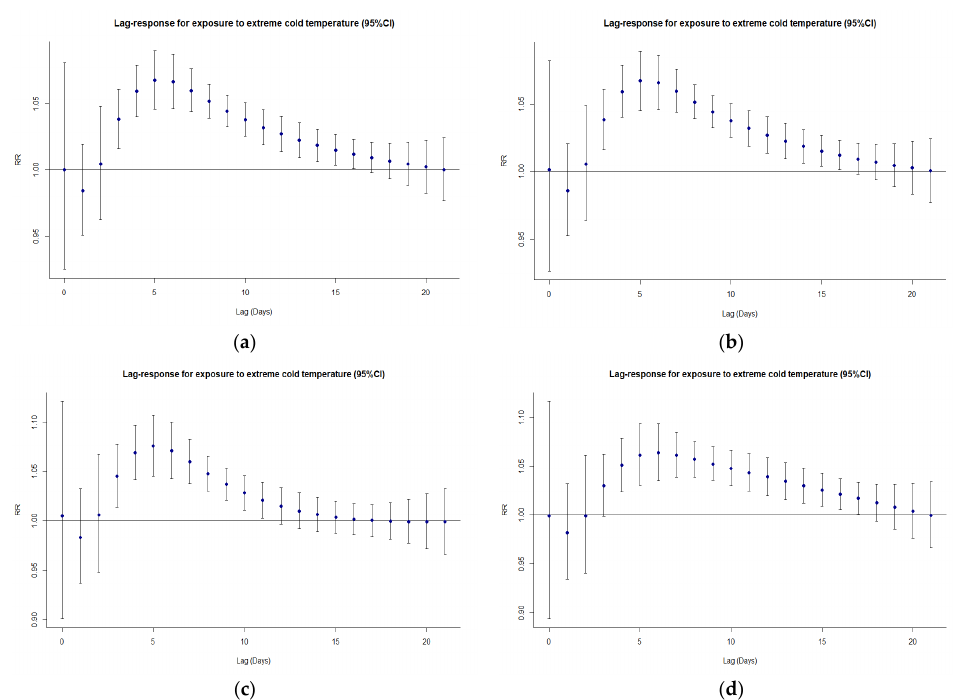
Figure 3. Lag-response curves for exposure to extreme cold (95% CI) for ( a ) the total population, ( b ) the elderly, ( c ) males, and ( d ) females.